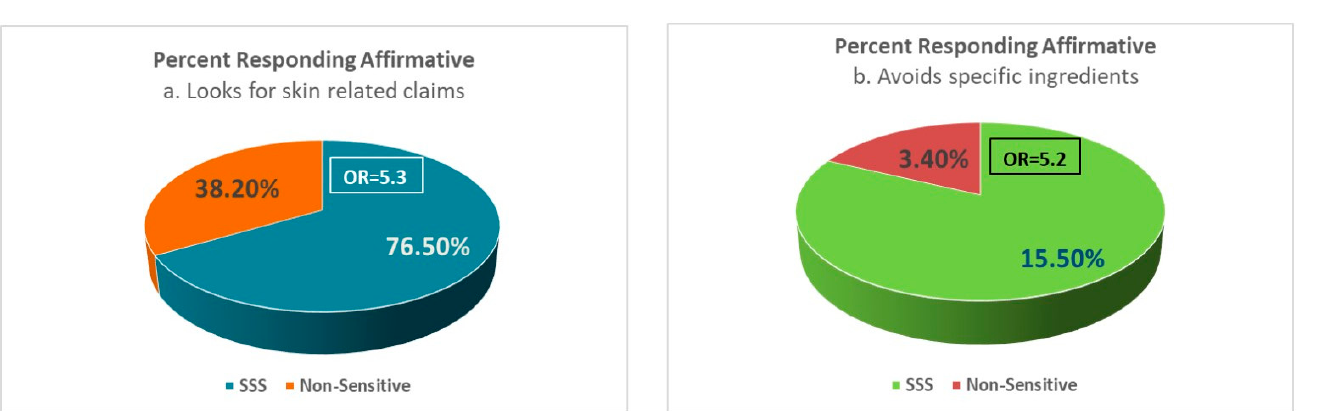
Figure 3. Product Categories Reported to Trigger SSS Symptoms. Responders in the Cincinnati study were asked if a variety of categories of cosmetics, personal care and household products had ever caused adverse reactions to their skin [35,36]. For all product categories the proportion of SSS individuals who responded positively was significantly higher than the number of non-SSS indi- viduals who responded positively. (* = p < 0.00001).